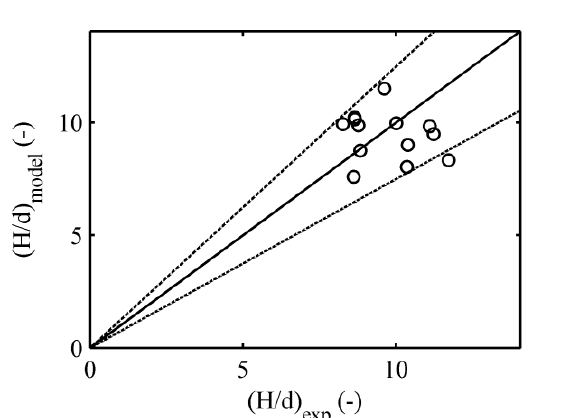
Fig. 14. Parity plot for predicted and experimental depth (normalized by grain size) of FA60 flow. Legend: lines of perfect fit and of ± 25 per cent deviation.